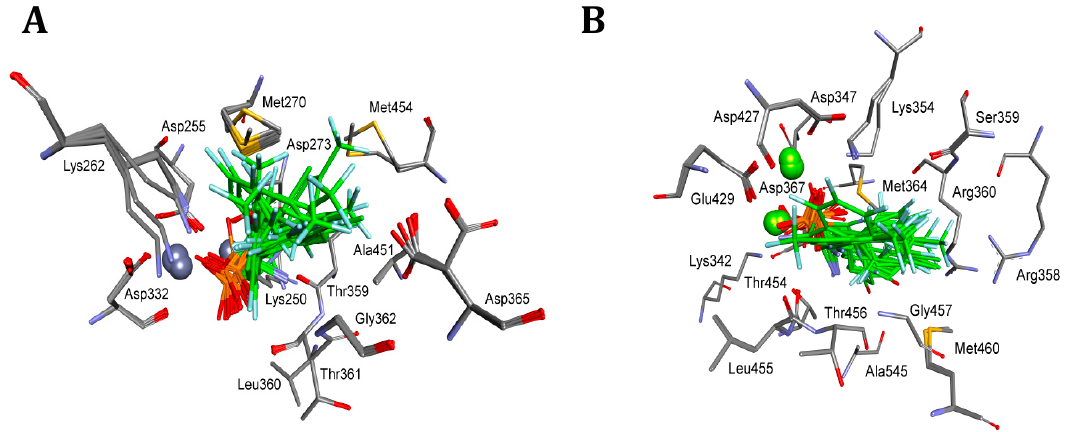
Figure 4. Modes of binding of all the studied analogs of phenylglycine (both enantiomers shown for each compound) to A —bovine lens leucine aminopeptidase (blLAP) and B —tomato leucine aminopeptidase (tLAP). All of the amino acids interacting with even one of the inhibitors are shown. Magnesium ions are shown as green spheres; other atoms are colored as in Figure 1.